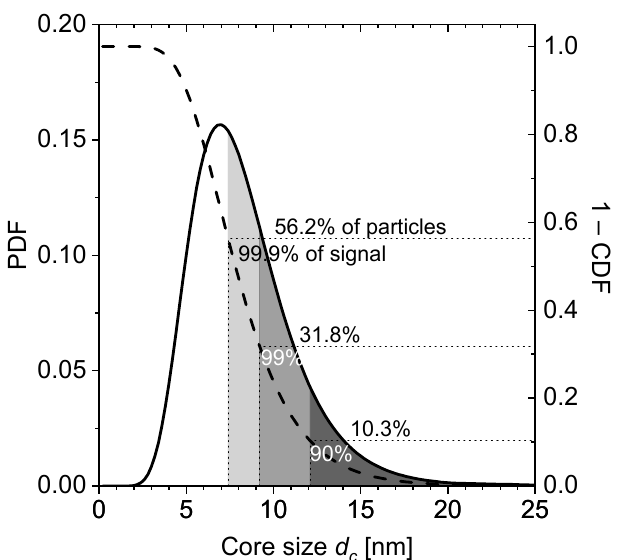
Figure 5. PDF of lognormal distribution (solid line) with d 0 = 7.81 nm and σ = 0.346 and its reverse CDF, counted from large sizes (dashed line). The quantiles which yield 90% (99%; 99.9%) of the FMMD signal are shaded in dark grey (grey; light gray), they consist of 10.3% (31.8%; 56.2%) of particles on the large-sized tail of the distribution.